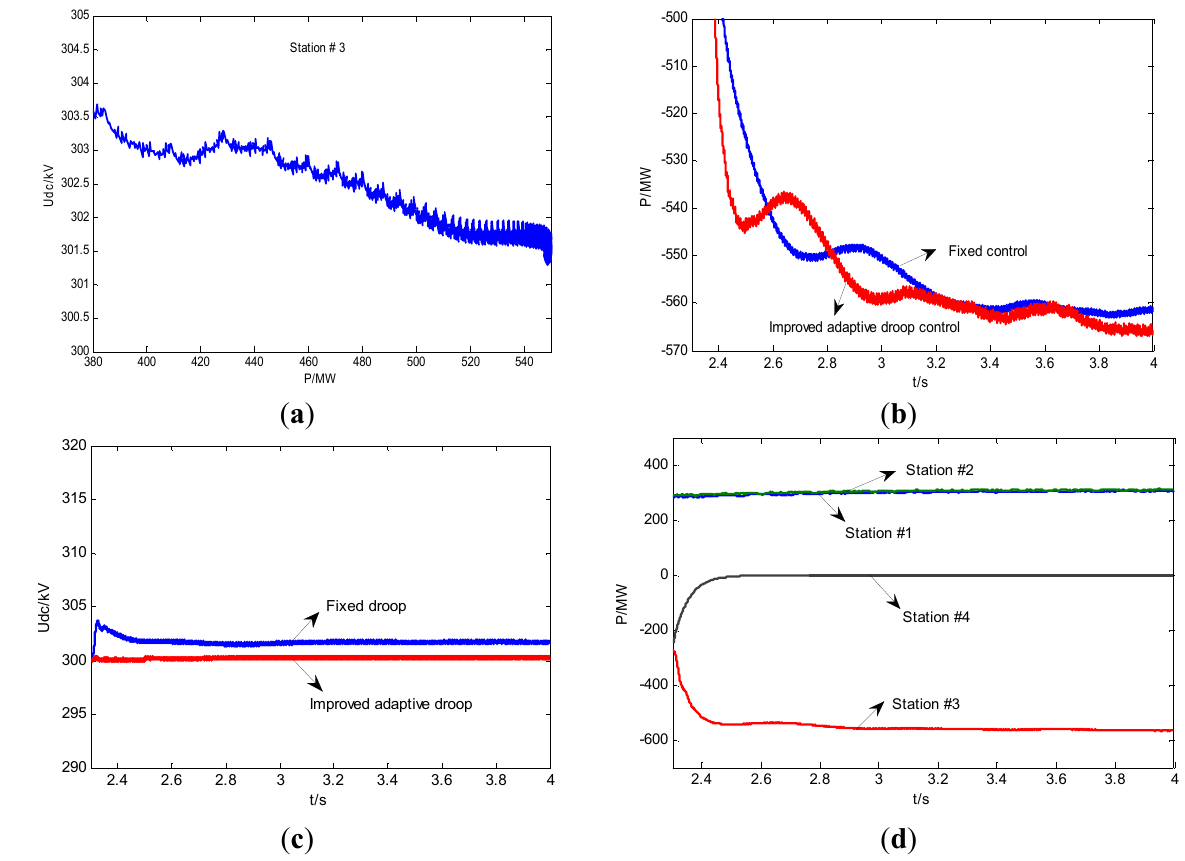
Figure 12. Dynamic responses of inverter outage ( a ) Voltage droop control of station #3; ( b ) Active power of station #3; ( c ) DC side voltage of station #3; ( d ) Active power of all stations.